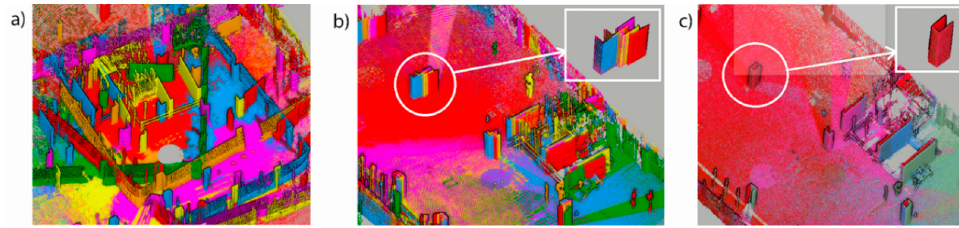
Figure 10. Automatic registration procedure: ( a ) initial state of the point clouds (all referenced to the (0,0,0), with relative coordinates regarding the position of the TLS in each acquisition); ( b ) state of the point clouds after the initial registration based on Harris 3D Noble–PFH, with a detail of the pillars where the error in registration is noticeable; ( c ) final result of the ICP registration, with a detail of the pillar shown in ( b ), which was correctly registered during this last step. Each colour represents a different point cloud.